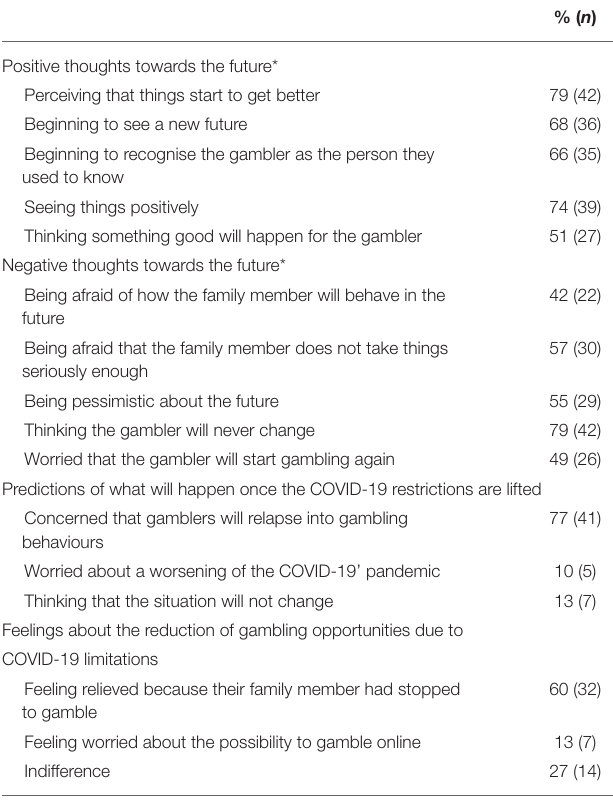
TABLE 6 | Expectations towards the future among the affected family